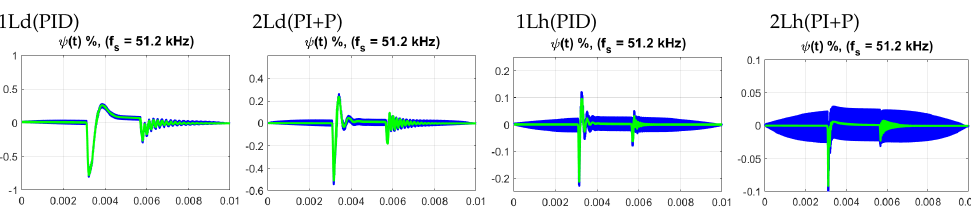
Figure 19. Zoomed-in views of the distortion function ψ ( t ) showed in Figure 18c for various structures at carrier frequency f s = 51.2